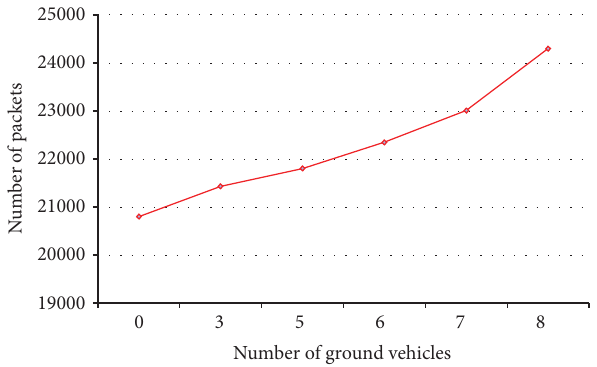
Figure 12: Transmission window